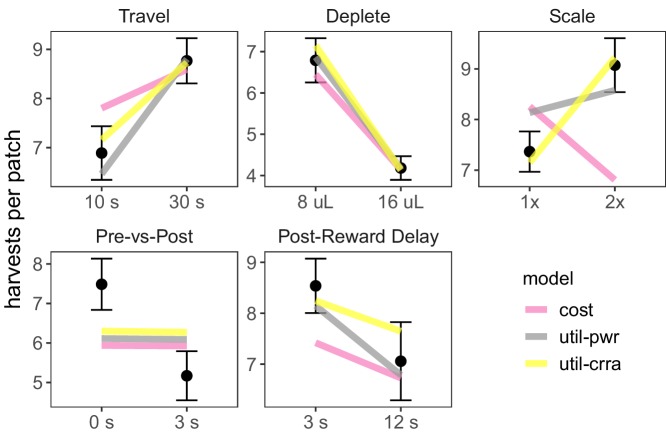
Predictions of the best fit subjective cost and nonlinear reward utility models (power law = util pwr; constant relative risk aversion = util CRRA). Black points and error bars represent mean ± standard error of observed behavior. Colored lines represent the mean model predicted behavior across rats.